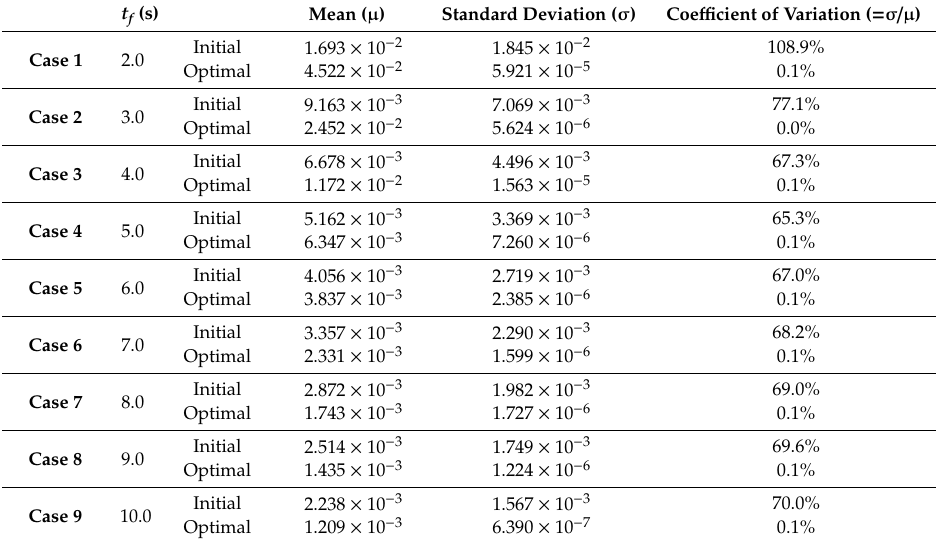
Table 7. Mean value, standard deviation, coe ffi cient of variation of the acceleration